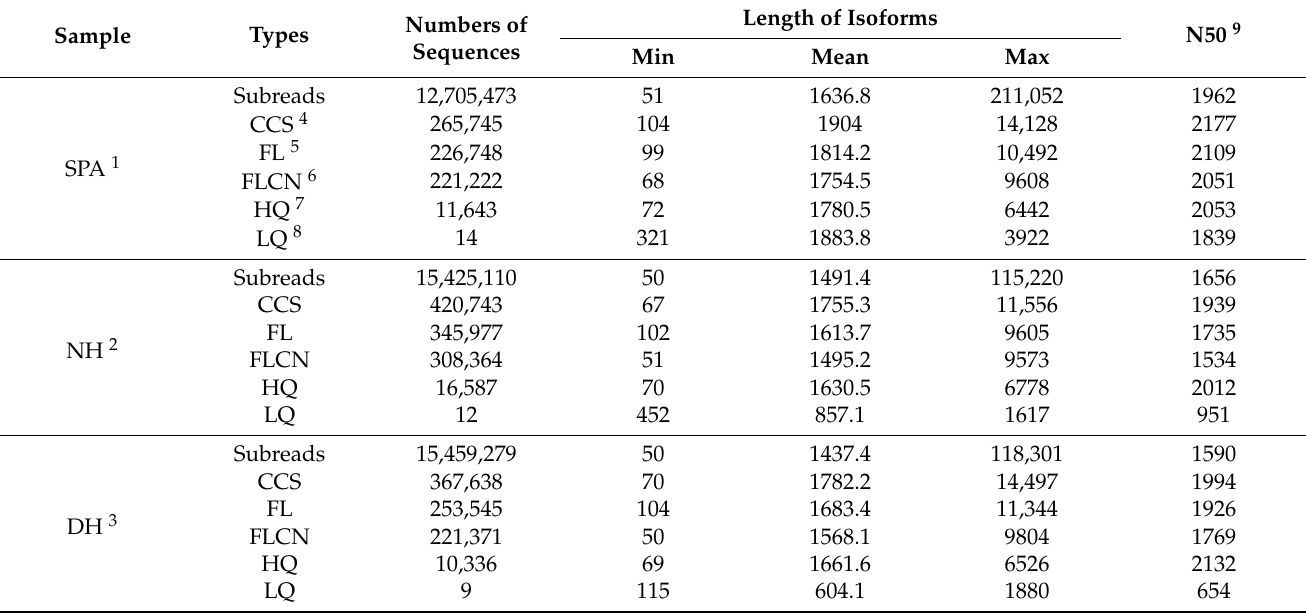
Table 1. Summary of PacBio sequencing data in SPA, NH, and